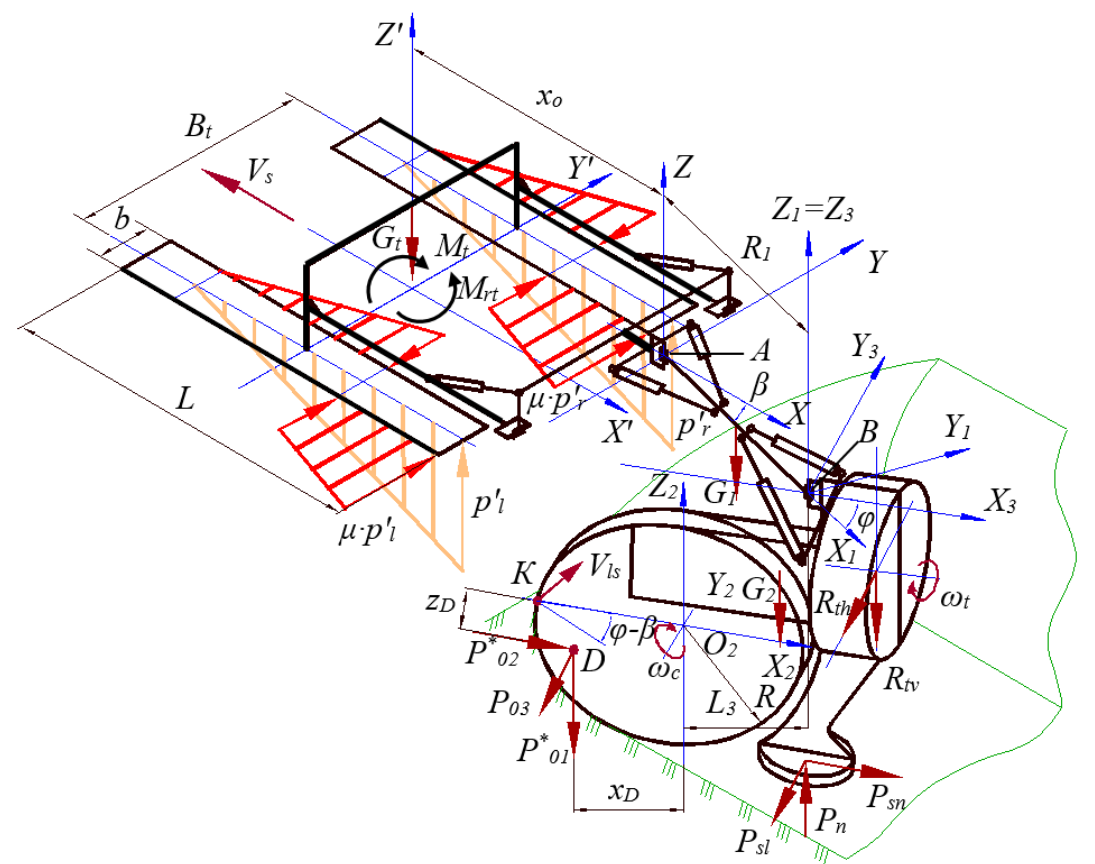
Figure 3. Calculation scheme of power loading of the machinery.